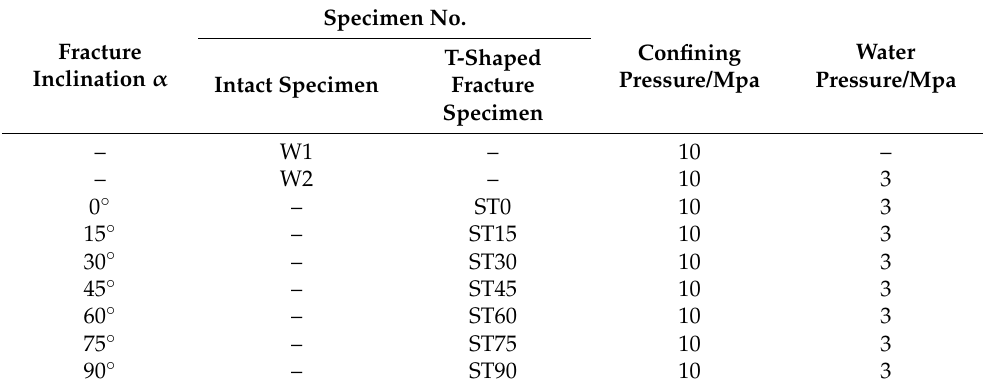
Table 1. Test scheme of fractured and intact sandstone specimens.